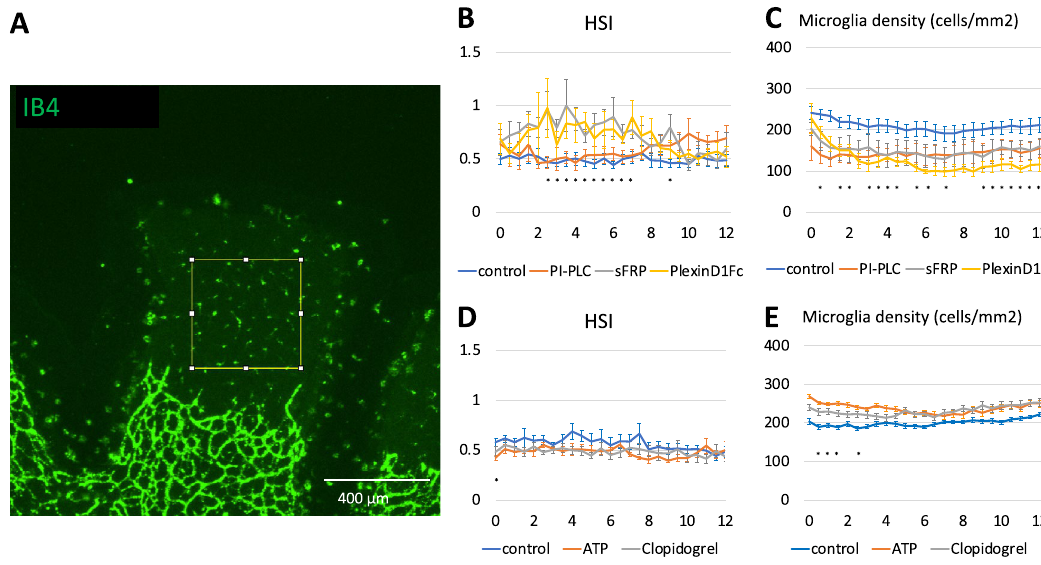
Figure 8. HSI and cell densities of microglia in organ culture. ( A ) Definition of measurement area. 400 µm × 400 µm areas were measured. ( B ) HSI change by affecting repulsion mechanism ( k ) (control: n = 7 , PI-PLC: n = 5 , sFRP: n = 5 , PlexinD1Fc: n = 4 ). ( C ) Cell densities change by affecting repulsion mechanism ( k ). ( D ) HSI change by affecting initial ATP concentration (control: n = 7 , ATP: n = 8 , Clopidogrel: n = 7 ). ( E ) Cell densities change by affecting initial ATP concentration. All data are represented as mean ± SE. *: one-way ANOVA, P < 0.05